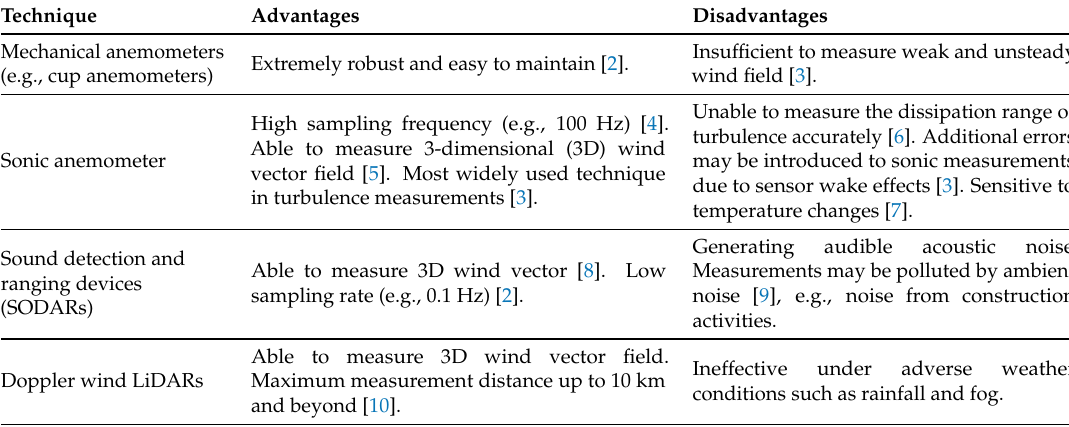
Table 1. A brief summary of wind measurement